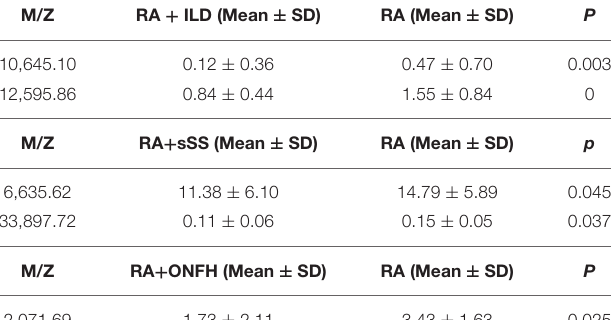
TABLE 6 | Biomarker statistics for RA vs. RA with complications spectra in the decision tree classification.